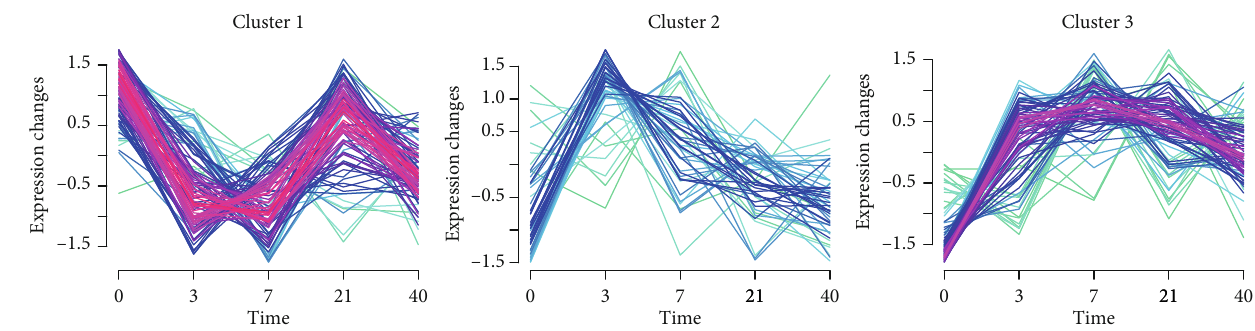
Figure 1: The results of Mfuzz clustering analysis. Three clusters with di ff erent change trends over time were screened out. The horizontal axis represents the days after spared nerve injury (SNI), and the vertical axis represents the relative expression value of cluster genes. The color from blue to red indicates that the membership value of this gene increases, which represents the gene ’ s importance in the cluster to some